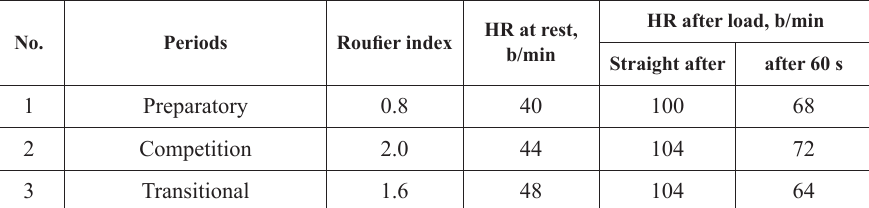
Table 4. A lternation of female BMX cyclist’s functional capacity of blood circulation system indices during yearly training